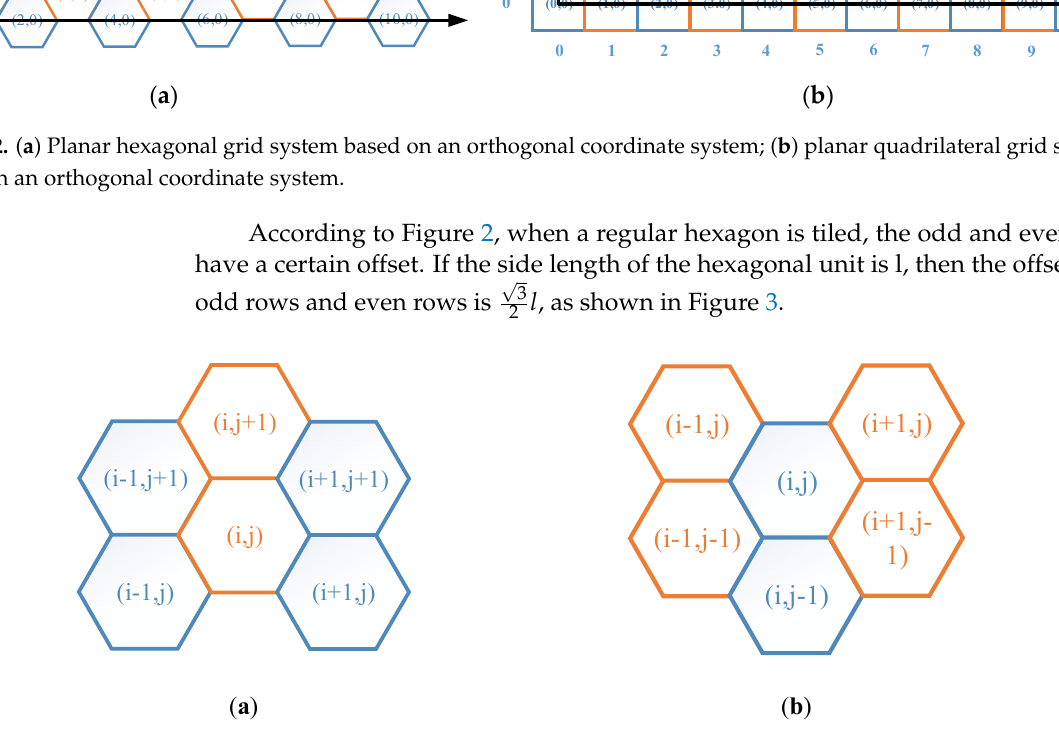
Figure 3. Misalignment relationship between odd and even rows, taking the hexagonal unit (i, j) as an example. ( a ) Schematic diagram of the grid structure in odd rows; ( b ) schematic diagram of the grid structure in even rows